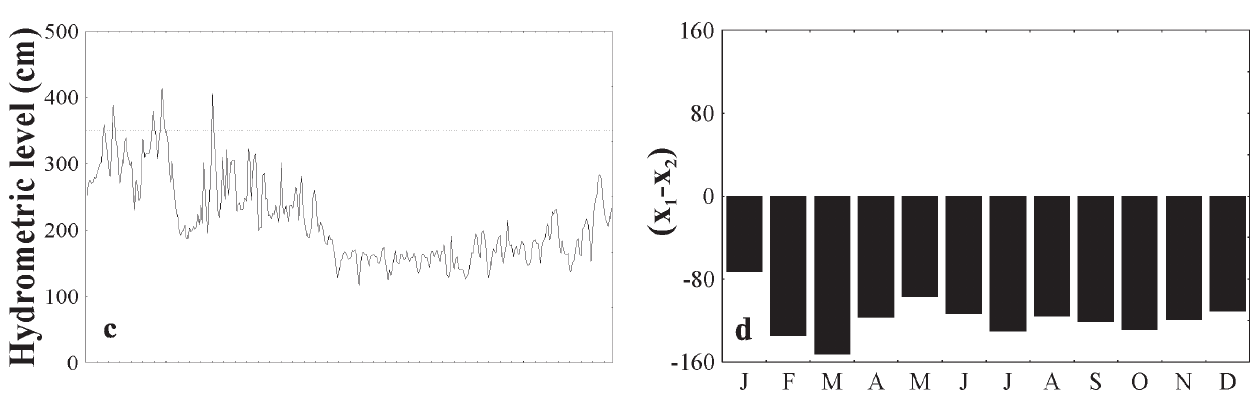
) and the last 10 1